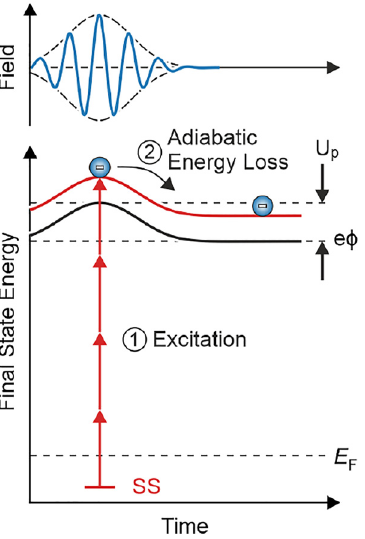
Figure 3: Energy-time diagram of the ponderomotive interaction in the adiabatic limit for 4th order electron emission. An electron is emitted at the maximum of the field envelope (step 1). As time progresses, the field envelope decays and the electron adiabatically , resulting in a down-shift of the loses the ponderomotive energy U p electron’s final-state energy (step